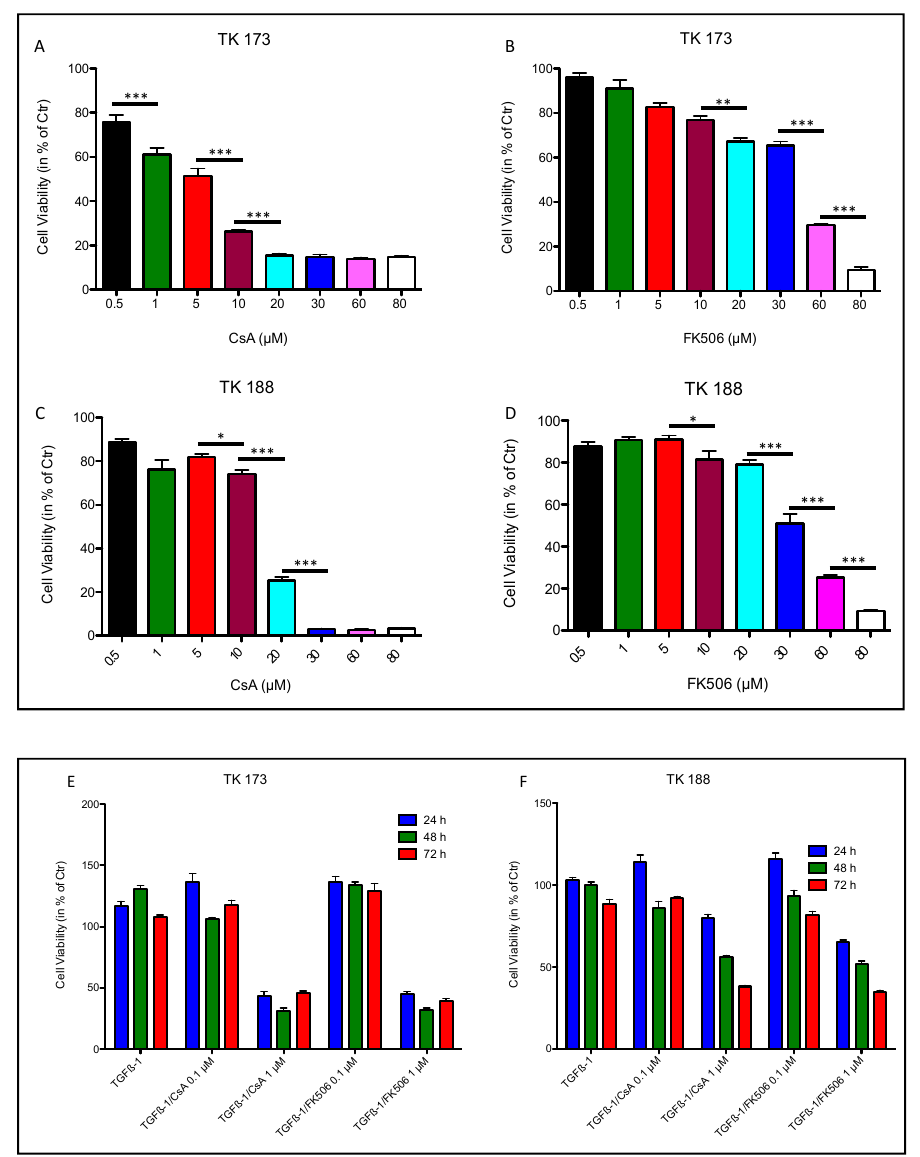
Figure 4. E ff ect of ciclosporin (CsA) and FK506 on renal fibroblasts cell line proliferation and viability. Renal fibroblast cell lines TK173 and TK188 were treated with variable ( A ) CsA or ( B ) FK506 concentrations (0.5–80 µ M) and the cell viability was assessed using 3-(4,5-dimethylthiazol-2-yl)-2, 5-diphenyltetrazolium bromide (MTT) assay. Concentrations > 0.5 µ M CsA and > 10 µ M FK506 significantlya ff ectthecellviability. ThefibroticcelllineTK188wasmoreresistanttothetreatments( C , D ); the viability was significantly impaired with CsA > 1 µ M, and FK506 > 10 µ M. The viability assay showed that the TK173 and TK188 survival under the TGF β 1 / CsA or TGF β 1 / FK506 combined treatment was dependent on the inhibitor concentration ( E , F ). * p < 0.05, ** p < 0.01, *** p <